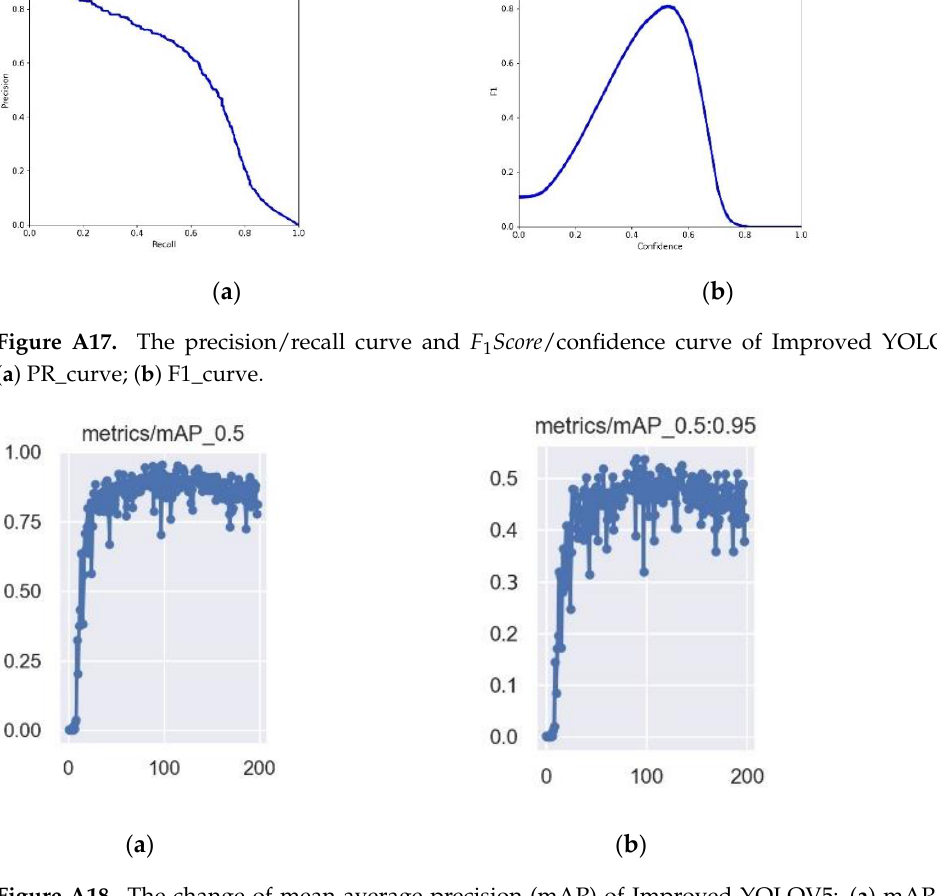
Figure A18. The change of mean average precision (mAP) of Improved YOLOV5: ( a ) mAP_0.5; ( b ) mAP_0.5:0.95.